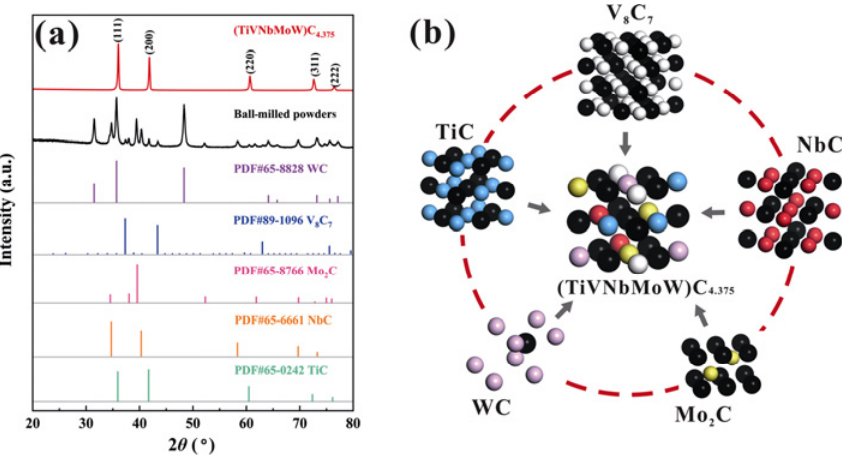
Fig. 2 (a) XRD patterns of ball-milled powders and sintered high-entropy (TiVNbMoW)C 4.375 ; (b) crystal structures of TiC, V 8 C 7 , NbC, Mo 2 C, WC, and high-entropy (TiVNbMoW)C 4.375